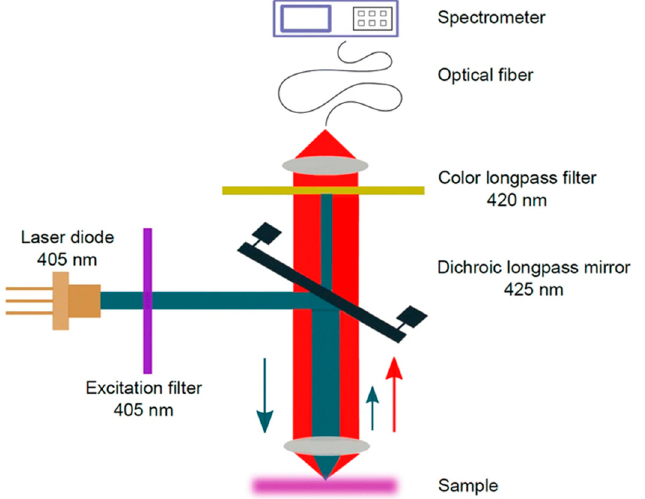
Figure 10. Scheme of the photoluminescence (PL) setup. The blue and red arrows indicate the propagation direction of laser and photoluminescence light, respectively [70]. Reprinted from Applied Physics B: Lasers and Optics, 126, Ornik, J.; Sommer, S.; Gies, S.; Weber, M.; Lott, C.; Balzer, J.C.; Koch, M. Could Photoluminescence Spectroscopy Be an Alternative Technique for the Detection of Microplastics? First Experiments Using a 405 Nm Laser for Exci-tation, 1–7. [70], Copyright (2019), with permission from